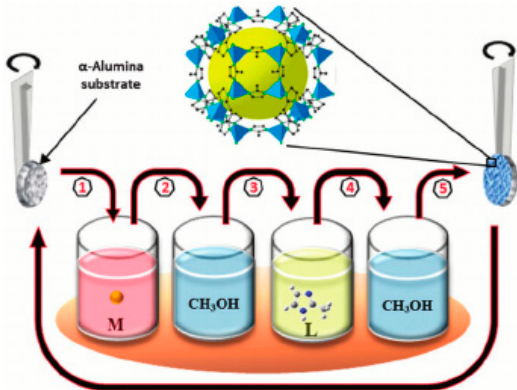
Figure 15. Schematic diagram for the automated layer-by-layer (LBL) growth of MOFs thin films on substrates functionalized with self-assembled monolayers (SAMs). The preparation is done by repeated immersion cycles first in a solution of the metal precursor and subsequently in the organic ligand solution, with solvent rinsing in-between (adapted with permission from ref. [53]).